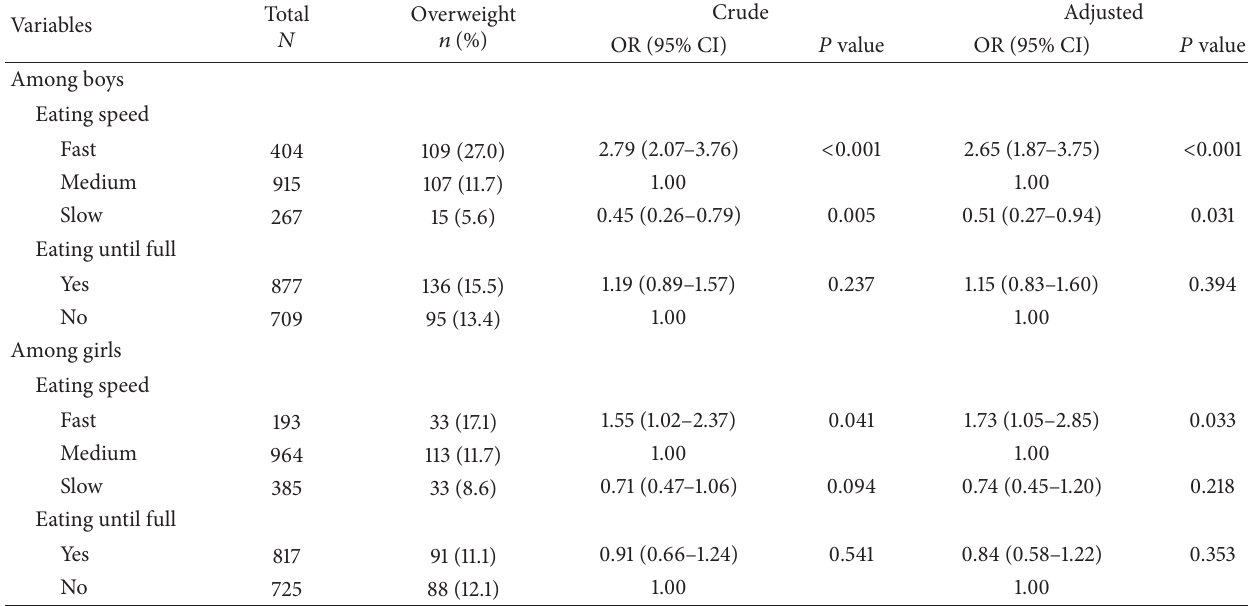
Table 3: Crude and adjusted odds ratios of eating speed or eating until full for being